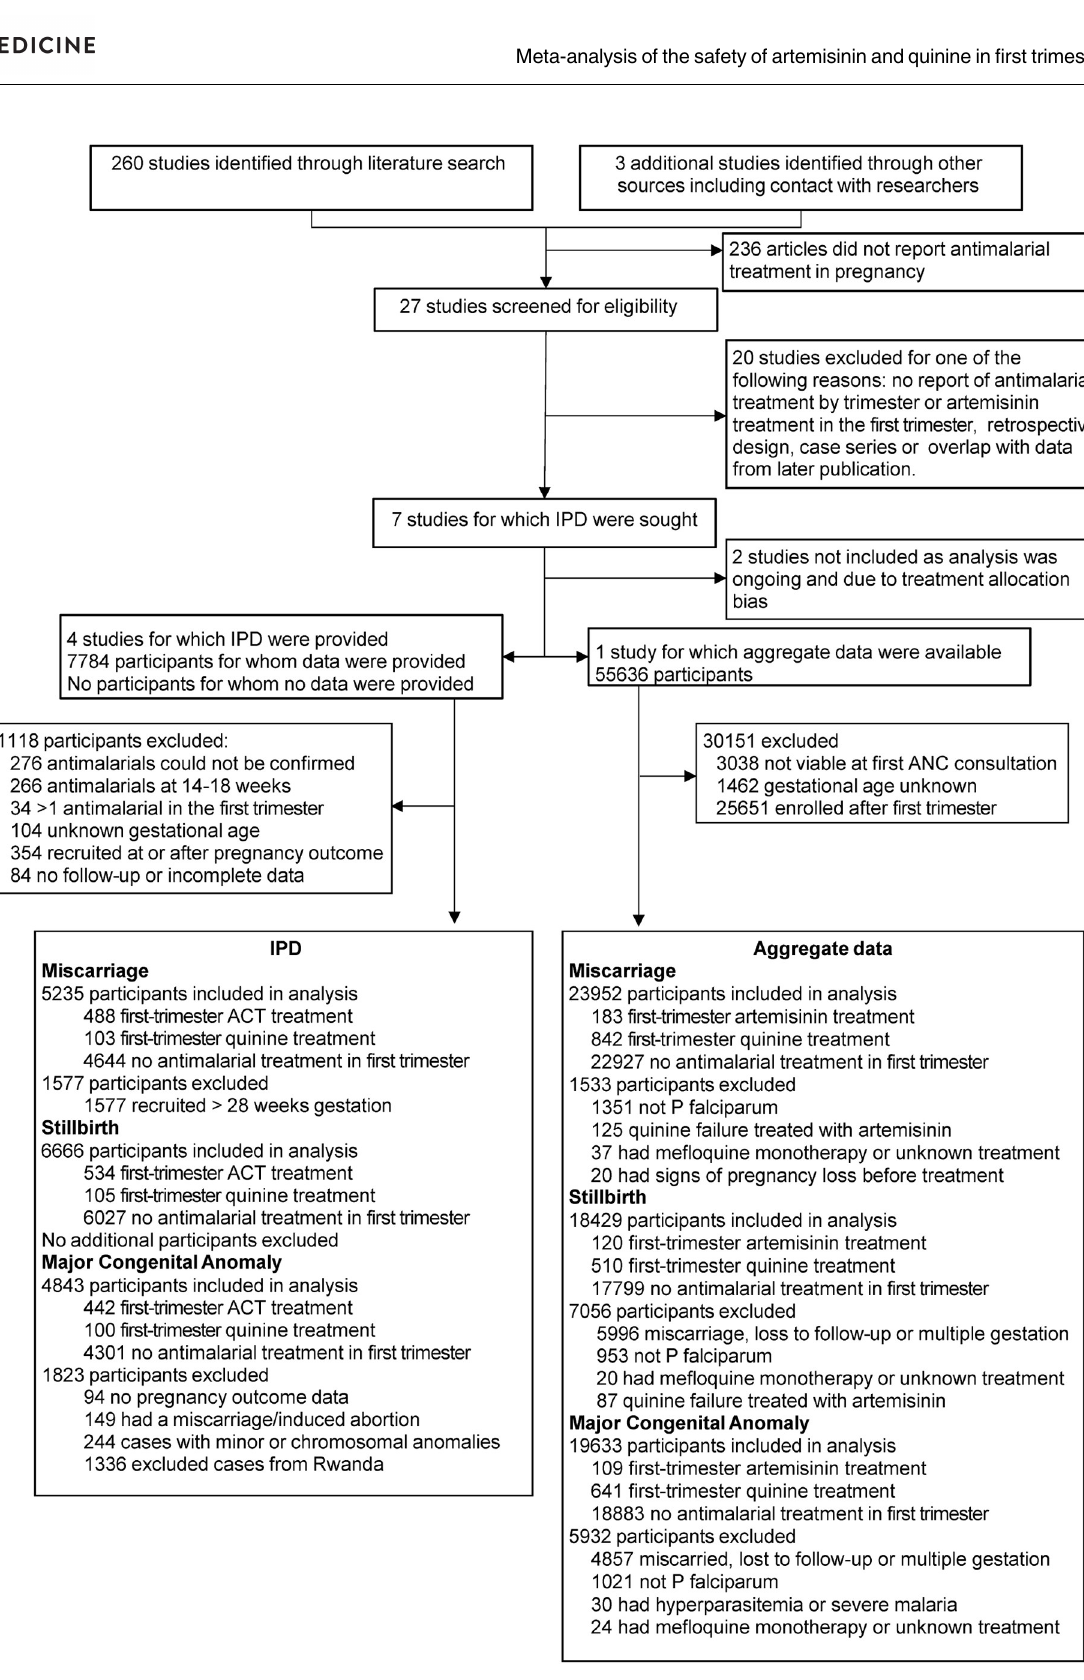
Fig 1. Flow diagram of studies and participants included in meta-analysis for miscarriage, stillbirth, and congenital anomaly. ACT, artemisinin combination therapy; ANC, antenatalcare; IPD, individual participant data.